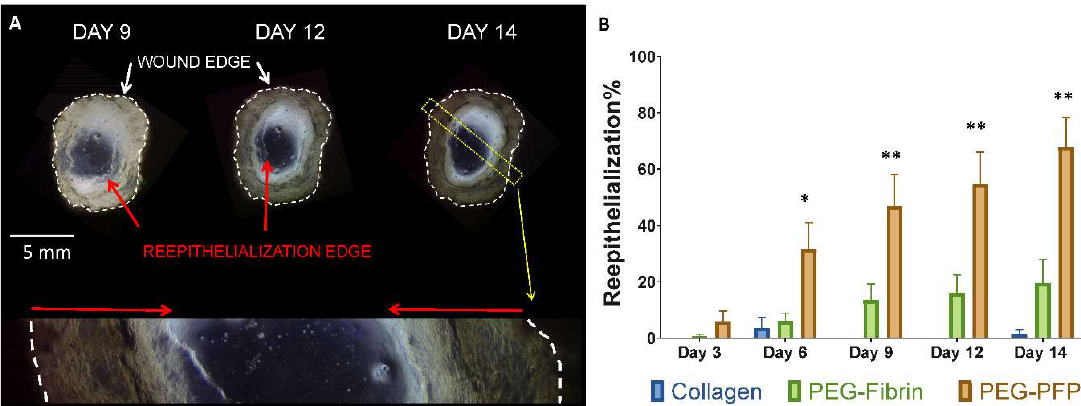
Figure 4. Re-epithelialization of ex vivo explants. ( A ) Representative microscopy images of a PEG-PFP treated wound that were captured over the time course and stitched together to create the above entire view of the ‘wound’. The white dotted lines represent the edges of the actual wound created by the biopsy punch. The red arrows are pointing to the leading edge of the newly formed epidermis. Light does not pass through the full thickness tissue and is reflected by the black regions around each wound. The bottom is an enlarged view of the yellow dotted rectangle from the day 14 image. The newly formed epidermis is highlighted by the red arrows indicating how much has been re-epithelialized by day 14. ( B ) Percent wound closure was quantified for all explants over the time course by measuring the total wound area and the area enclosed by the leading edge of the neo-epidermis. PEG-PFP was significantly different from all other treatment groups. * p < 0.01; ** p < 0.001, N = 5.